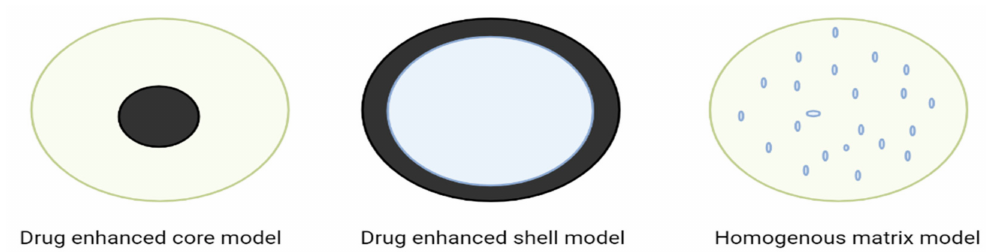
Figure 3. Types of solid lipid nanoparticles.